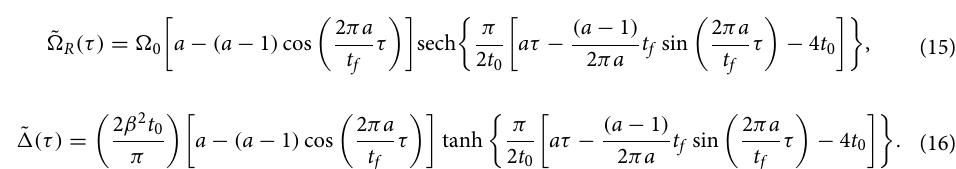
Figure 2. Behavior of the TR functions ˜ (cid:31) R and ˜ (cid:31) with the contraction parameter assuming the values ( a ) a 10 . In both cases we note that the dynamics occur a times faster than the reference control process and ( b ) a = described in Fig. 1a, with the same initial and final conditions. Same parameters as in Fig.